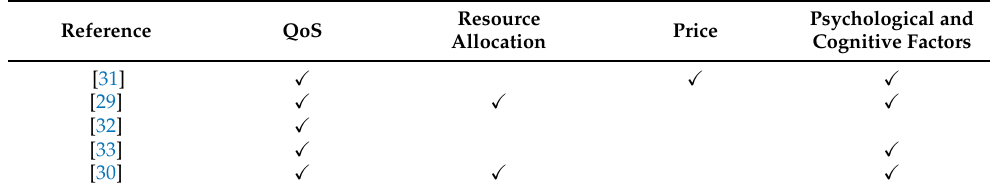
Table 2. The QoE indicators discussed in various works. The tick marks and the blank cells indicate the inclusion and non-inclusion of the respective QoE indicators in the